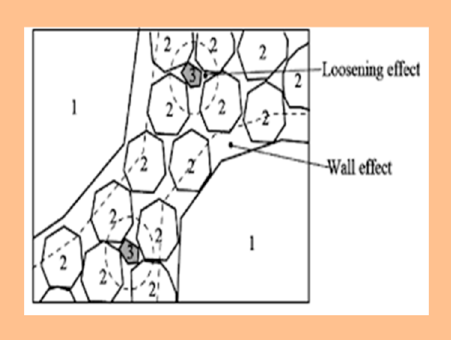
Figure 1. Wall and Loosening Effect